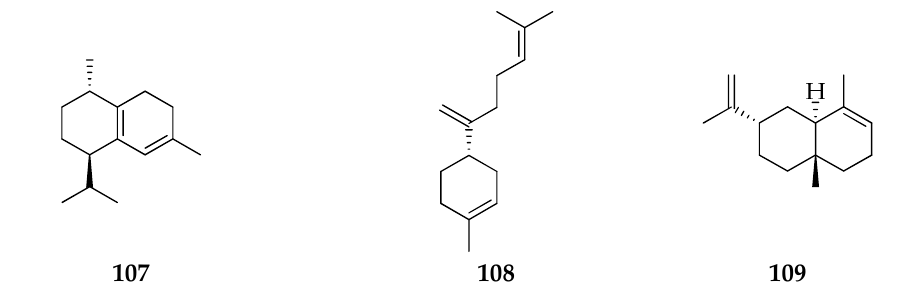
Figure 4 . The compounds in different varieties of black rice bran use different isolation methods.